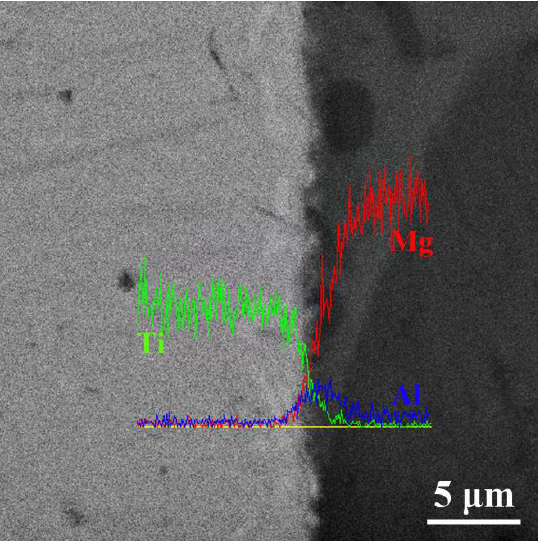
Figure 5. Line scan curves of the interface between Mg-9Al matrix and Ti rod obtained after 60 min at 700 °C.